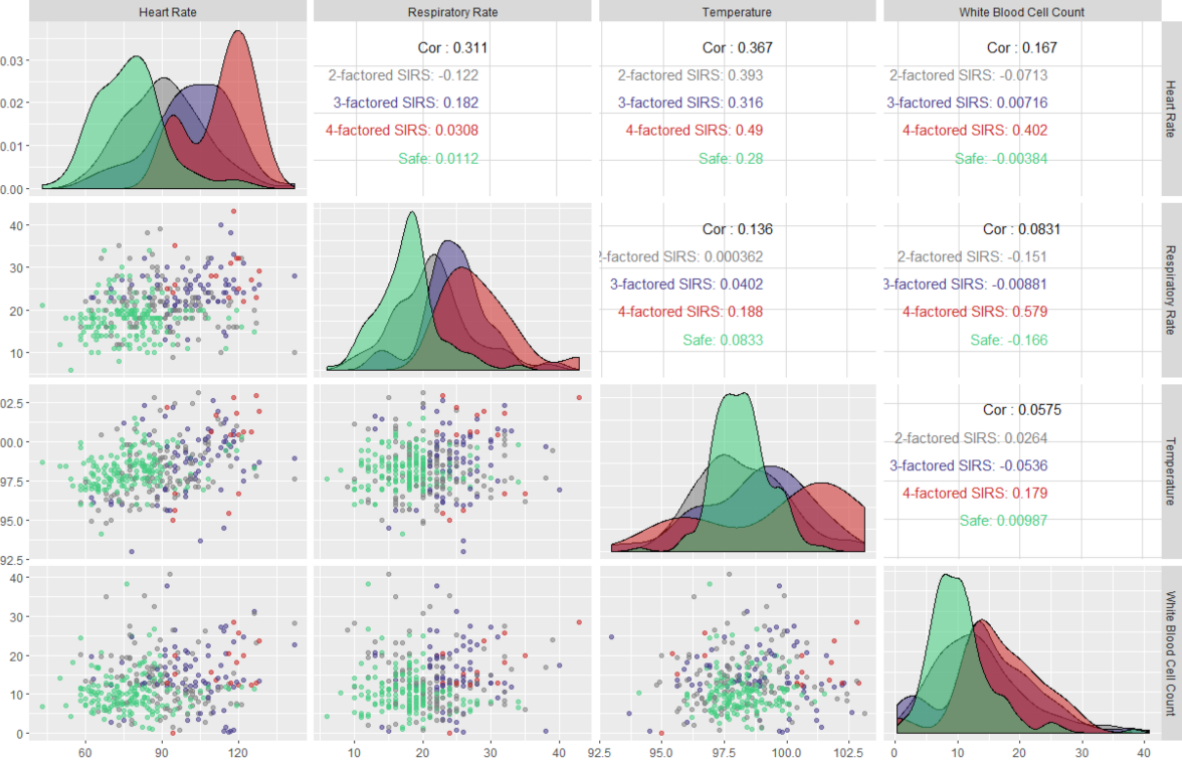
Figure 10. Facet grid illustration of sepsis-2 (SIRS) parameters to capture the underlying relationship between parameters and the most prevalent sepsis scenario of patients at first observations in the intensive care unit. SIRS: systemic inflammatory response